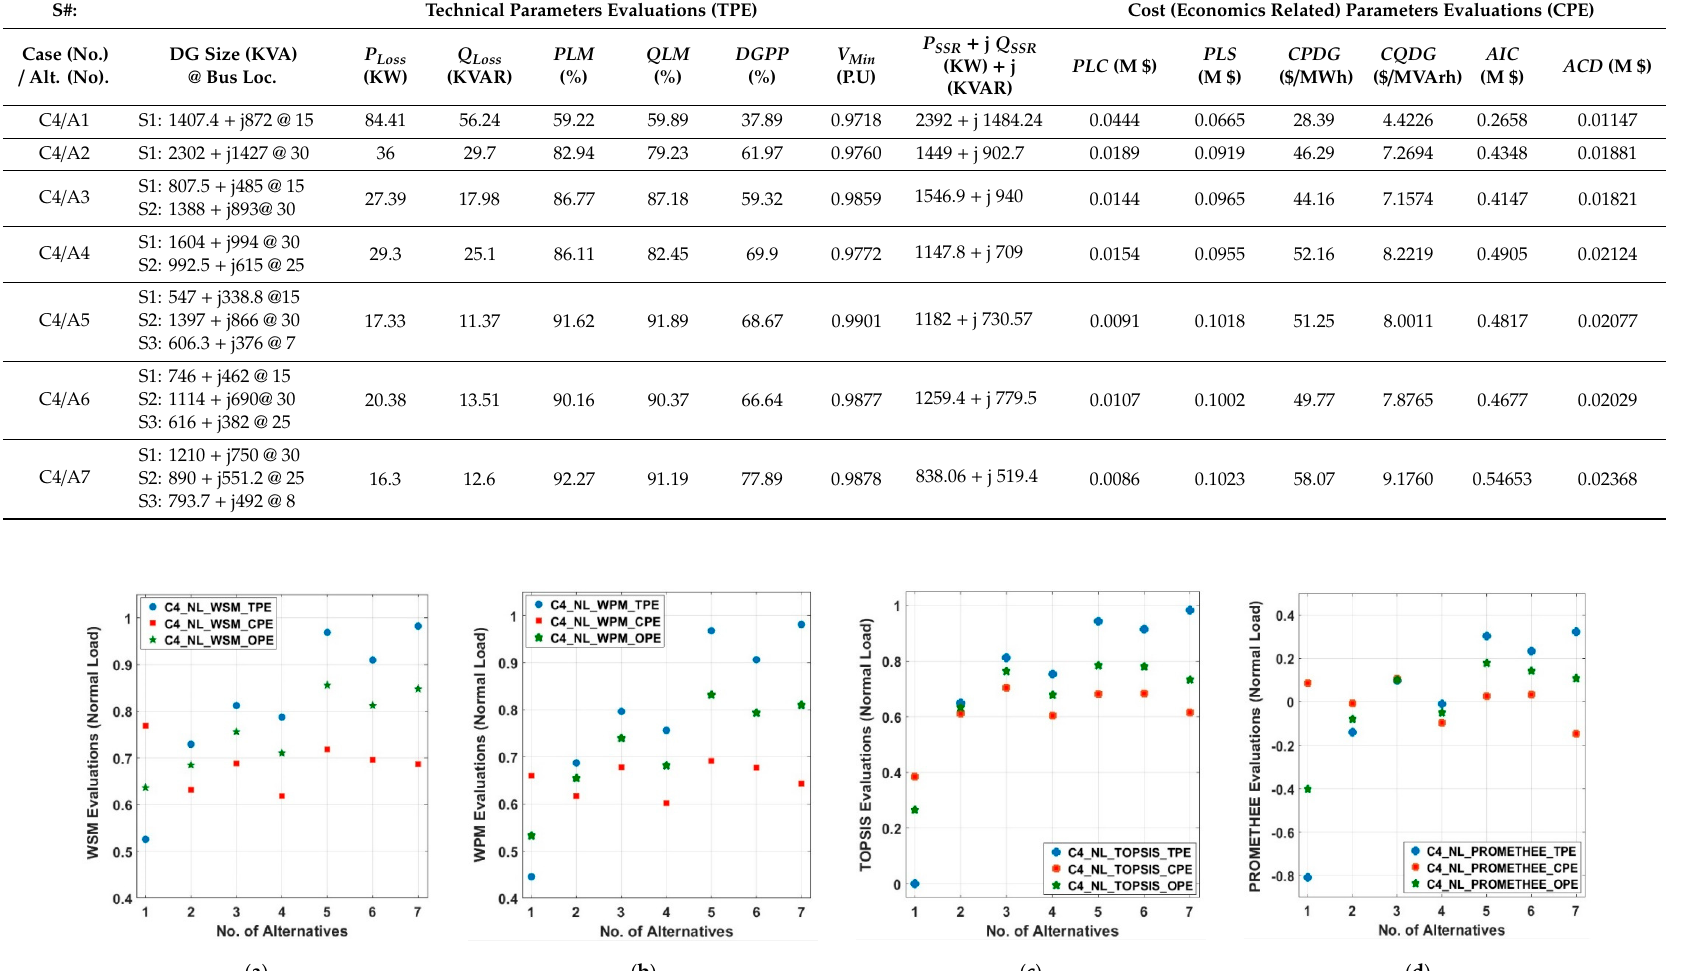
Table 11. Techno-economic evaluation analysis in case 4 (C4_NL) for 33-bus MDN.